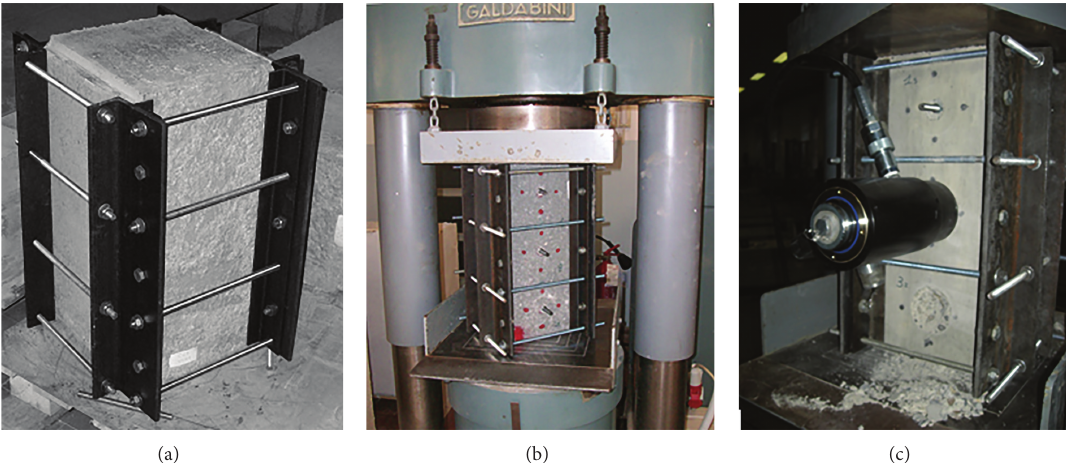
Figure 8: Testing setup for compressed prisms; (a) confining frame; (b) specimen in the press; (c) loaded specimen, extracting jack, anchor